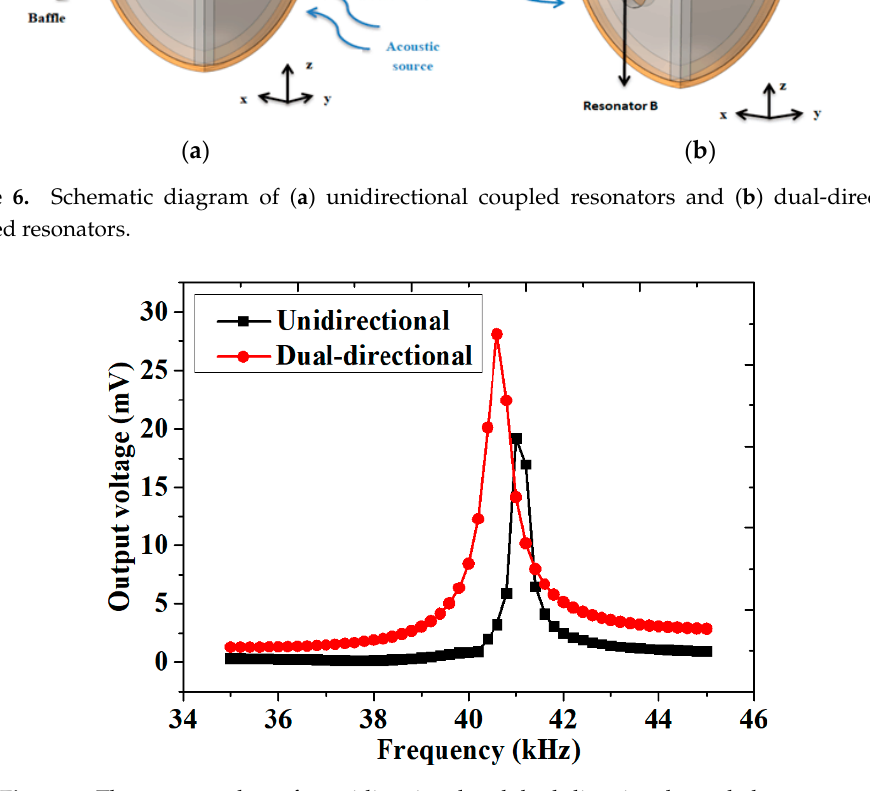
Figure 7. The output voltage for unidirectional and dual-directional coupled resonators.